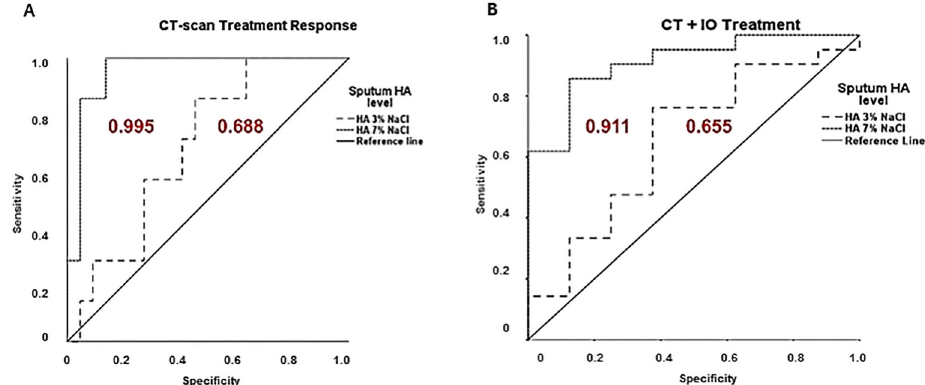
Figure 4. Receiver operating characteristic curves for sputum levels of hyaluronan (HA). A , The cut-off level of HA in 7% NaCl that resulted in the highest diagnostic accuracy was 73.30 ng/mg compared to HA in 3% NaCl. This cut-off point discriminated between complete response on computed tomography scan (CT-scan) and progressive disease, with 100% sensitivity and 86% speci fi city. The diagnostic accuracy was 95%. B , The cut-off level of HA in 7% NaCl that resulted in the highest diagnostic accuracy was 44.70 ng/mg. This cut-off point discriminated between CT and CT + IO treatment, with 85% sensitivity and 87% of speci fi city. The diagnostic accuracy was